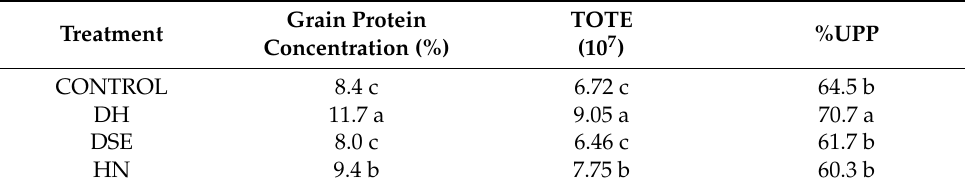
Table 3. Mean values of grain protein concentration, as well as of total SDS-extractable proteins (TOTE) and percentage of SDS-unextractable polymeric protein in total polymeric protein (%UPP) obtained from size exclusion-high performance liquid chromatography for wheat subjected to different treatments; control, drought at heading (DH), drought at stem elongation (DSE), and with high nitrogen application (HN). Numbers within the same column followed by the same letter do not differ significantly at p < 0.05 by Duncan post hoc test.